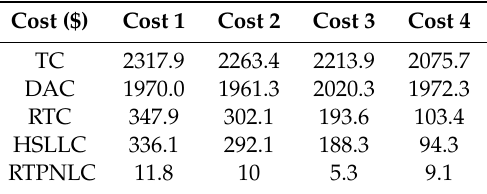
Figure 6. The daily power loss of the ADN in these four cases.